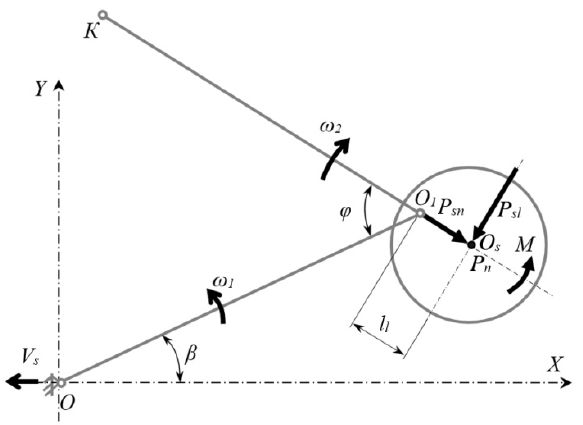
Figure 8. Calculation scheme for determining the loading of the sweeping shoe.